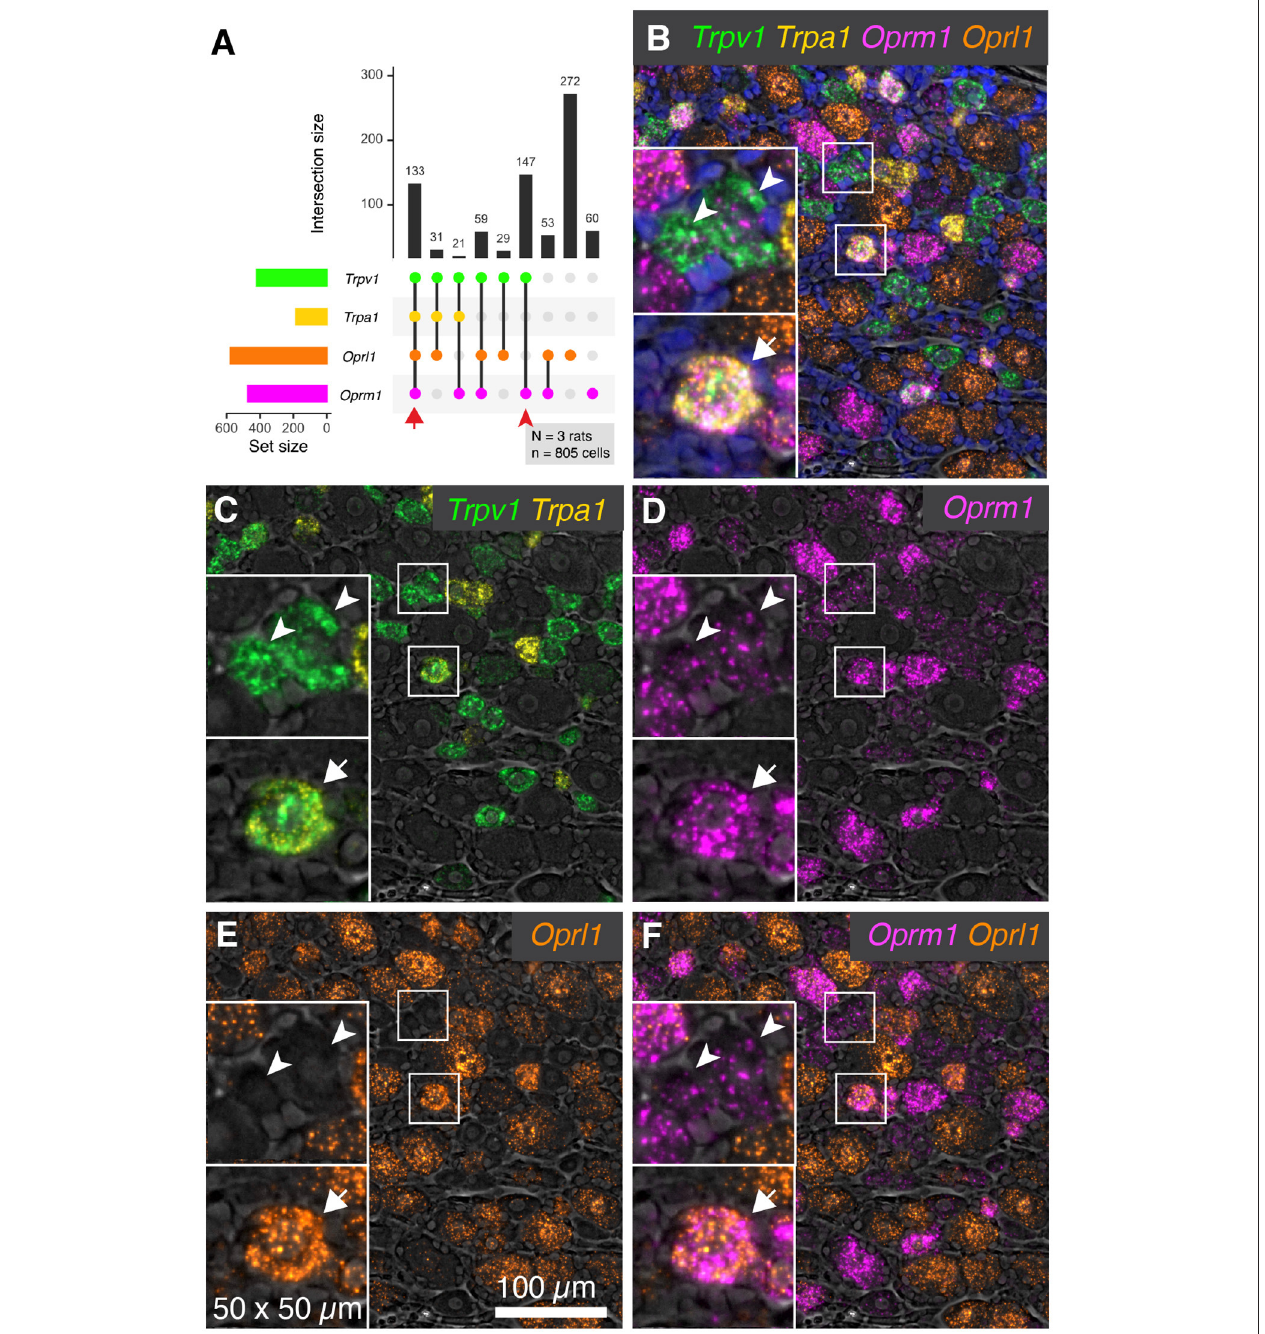
FIGURE 4 | Co-expression patterns of nociceptive ion channels and opioid receptors. To assess the overlap between nociceptive transducing ion channels and opioid receptors, multiplex fluorescent hybridization was performed for Trpv1 , Trpa1 , Oprm1 and Oprl1 . This analysis was performed in N 3 rats total, and 805 cells. = (A) Counts were tabulated for co-expression of these four markers in each cell, and the intersections of these are plotted. The most prevalent count group was Oprl1 alone, due to the near-ubiquitous nature of this marker (272 cells). Cells positive for all four labels (133 cells) were also prevalent, indicating overlap between nociceptive ion channels ( Trpv1 and Trpa1 ) and the mu-opioid receptor Oprm1 as well as Oprl1 . Populations containing Trpv1 and Oprm1 with or without Oprl1 (59 cells with all three and 147 cells with Trpv1 / Oprm1 only) were also prevalent, reinforcing the overlap between these two markers. (B) A representative panel showing a diverse field of cells is shown, with quad-positive neurons highlighted (arrows). Additionally, Trpv1 / Oprm1 cells are indicated (arrowheads). (C–F) To increase the visibility of the + + highly multiplexed image, individual channels and channel pairs are shown for the image in (B) , with the channel identity found in the bottom right of each panel. (C) A panel showing only Trpv1 and Trpa1 was selected to show the relationship between these two nociceptive ion channels. (D) A range of intensities was observed for Oprm1 . Note the presence of less prominent puncta in Trpv1 / Oprm1 cells (arrowheads). (E) Oprl1 alone. (F) Oprm1 and Oprl1 . Scale bar applies to all + +